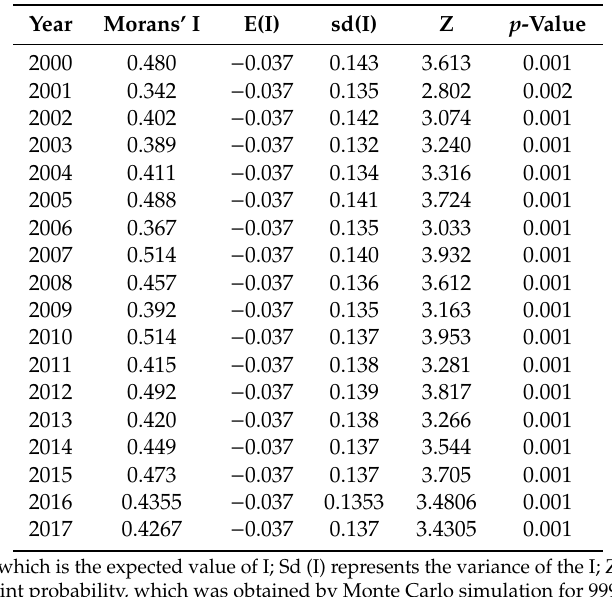
Table 1. Global Moran’s I for PM 2.5 in Beijing-Tianjin-Hebei region and surrounding cities.